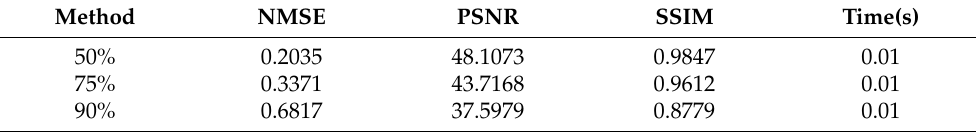
Figure 8. ISAR images of Figure 3b with different loss rates and different SNRs. Table 7. Performance evaluation for the simulated data with different loss rates under the 5 dB condition.